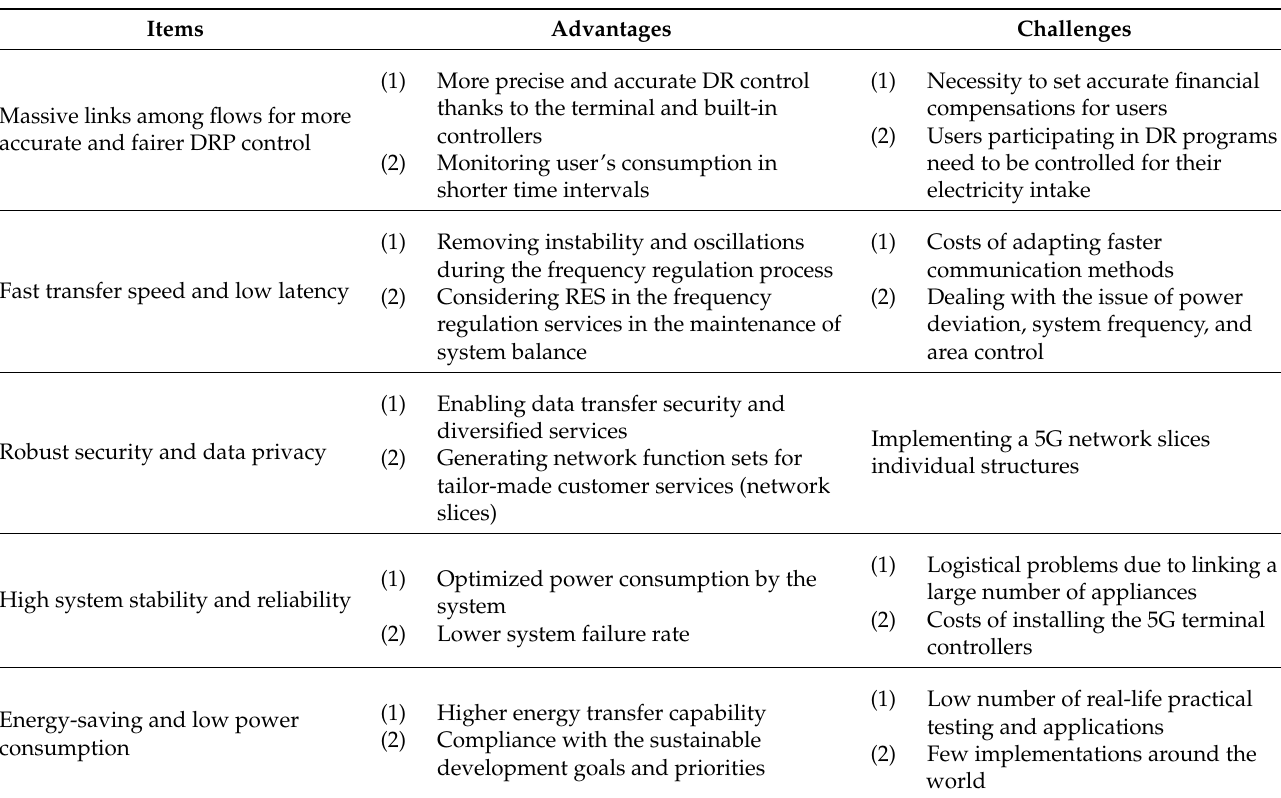
Table 6. Comparison of 5G-based IoT-enabled smart grids for the